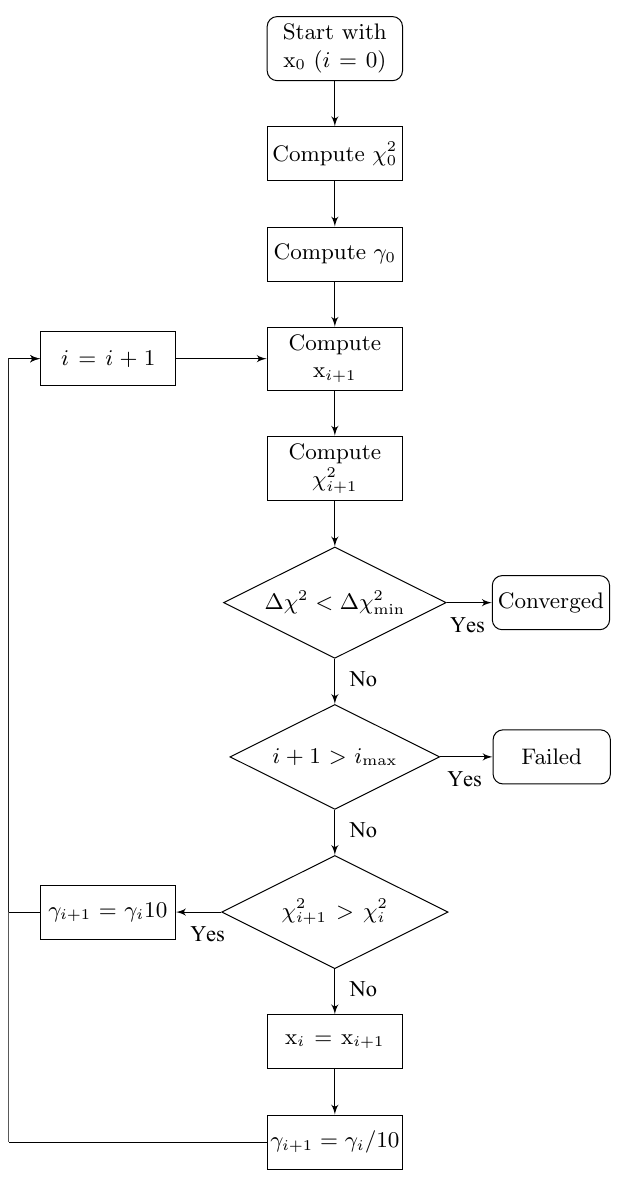
Figure 5. The ORAC inversion system depicted as a flow chart. Rectangles with corners are processes, diamonds are decisions and rectangles with rounded corners are start and top